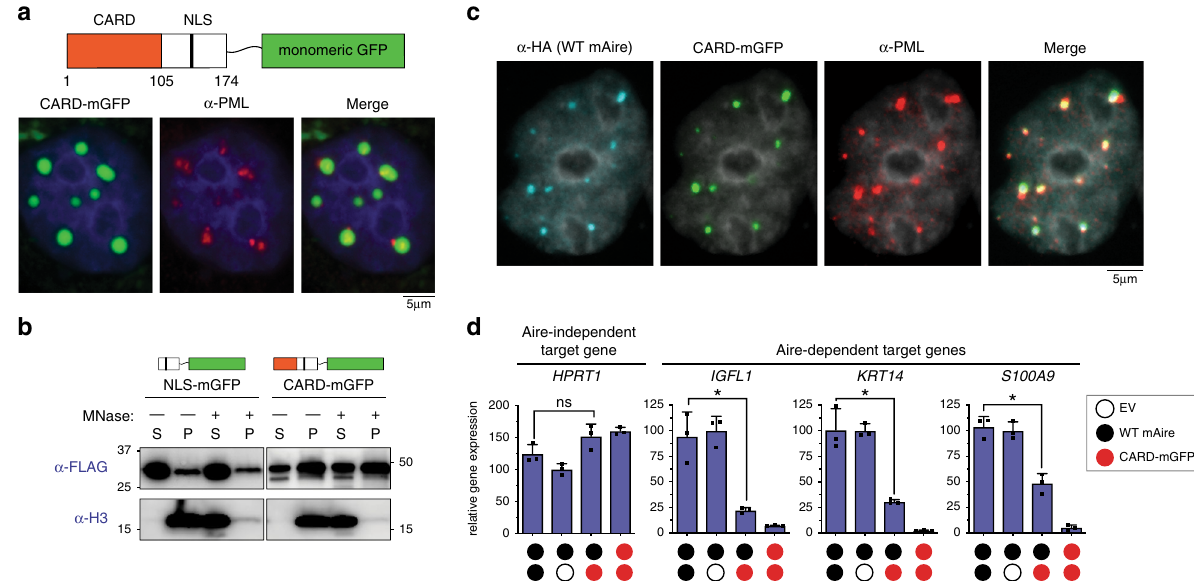
Fig. 5 Isolated Aire CARD multimers associate with PML bodies. a Representative fl uorescence microscopy images (3 independent experiments) of mAire CARD fused with monomeric GFP (CARD-mGFP) transiently expressed in 4D6 cells. Note that mAire residues 1 – 174 containing both Aire CARD and nuclear localization signal (NLS) were used in the fusion construct. GFP fl uorescence and anti-PML staining were used for imaging CARD-mGFP and PML bodies, respectively. b Chromatin fractionation analysis of NLS-mGFP (mAire aa 105 – 174 fused with mGFP) and CARD-mGFP. Experiments were performed as in Fig. 3d. c Representative fl uorescence microscopy images (two independent experiments of CARD-mGFP and HA-tagged mAire upon their co-expression in 4D6 cells. GFP fl uorescence was used for imaging CARD-mGFP and immunostained with anti-HA and anti-PML. d Transcriptional activity of mAire (black circle) and its changes upon co-expression with CARD-mGFP (red circle) in 293 T cells. Each circle represents 0.6 μ g/ml DNA transfected. Experiments were performed as in Fig. 1g and presented as mean ± s.d., n = 3. P -values (two-tailed t -test) were calculated in comparison to WT mAire. * p < 0.05; p > 0.05 is not signi fi cant (ns). Exact p -values are provided in the Source Data